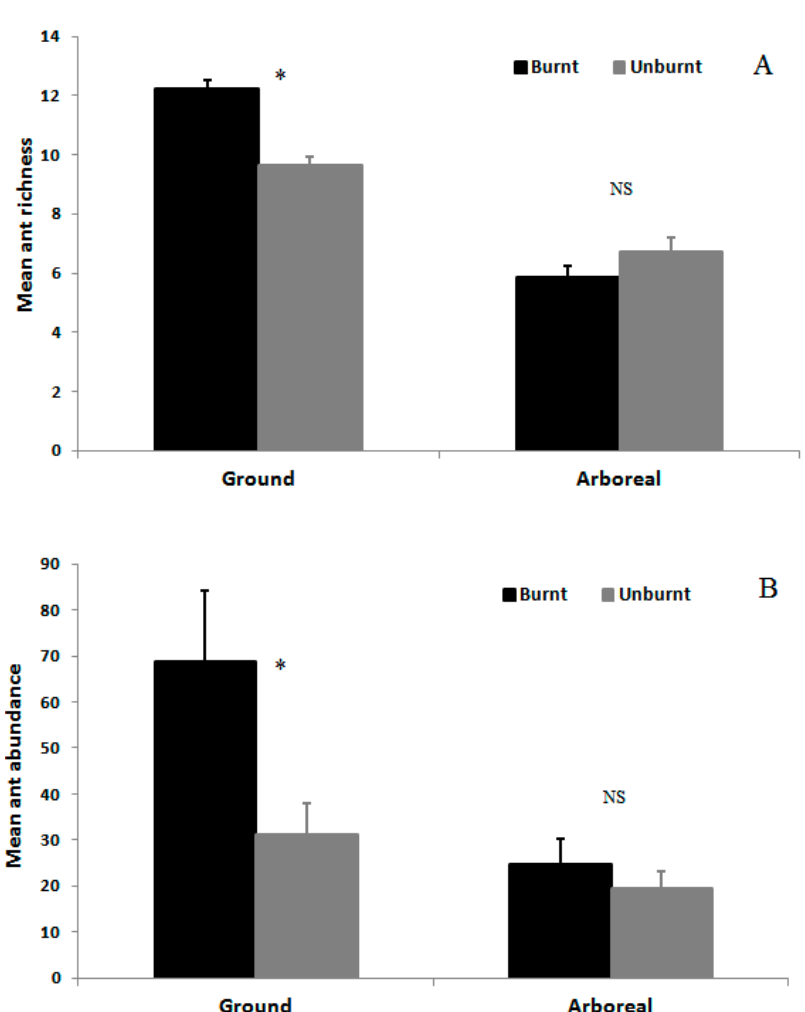
Figure 2. Average richness ( A ) and abundance ( B ) of ground and arboreal ant species in the burnt area (dark bars) and unburnt area (gray bars). Asterisks indicate significant differences between groups ( p < 0.05). NS = not significant. Insects 2017 , 8 , 64